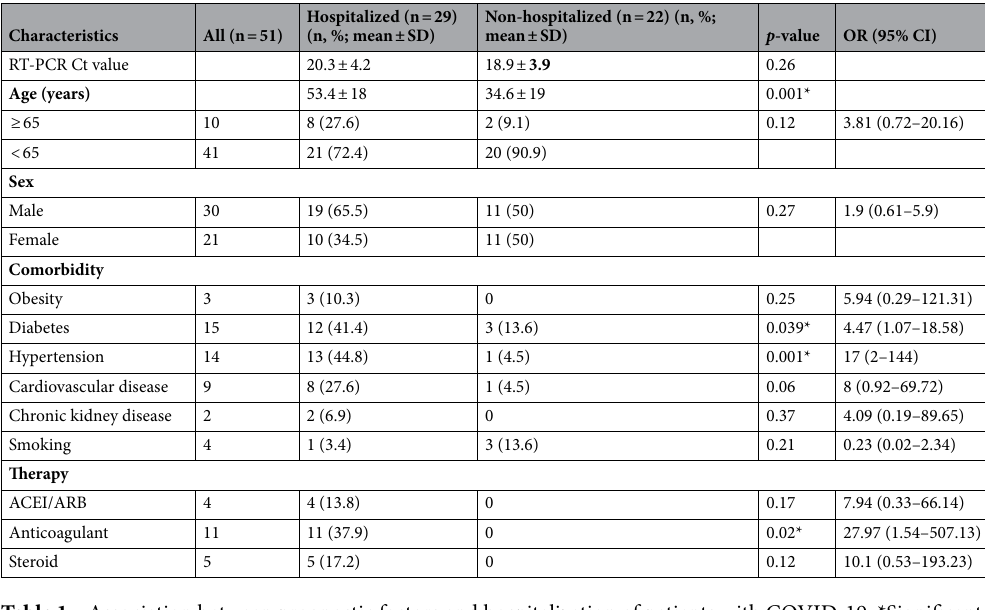
Table 1. Association between prognostic factors and hospitalization of patients with COVID-19. *Significant ( p < 0.05). ACEI angiotensin-converting enzyme inhibitors, ARB angiotensin receptor blocker, CI confidence interval, OR odds ratio.